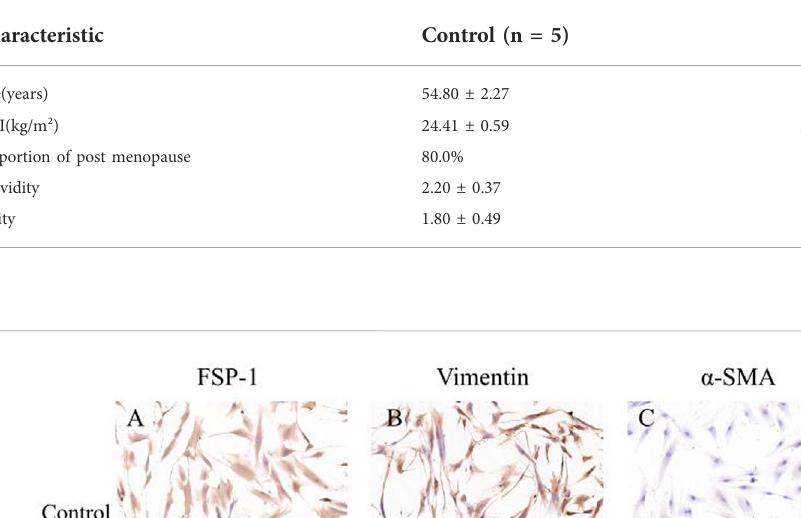
TABLE 2 Clinical characteristics of enrolled